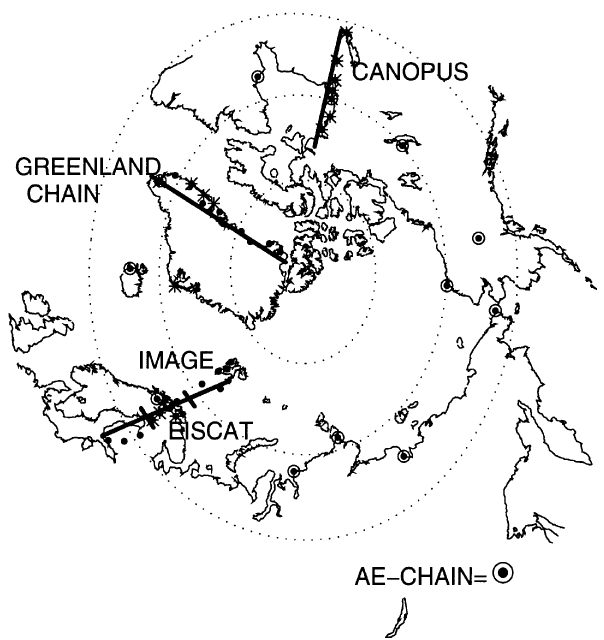
Fig. 1. The AE stations and the IMAGE/EISCAT (EISCAT is the shorter part within the tick marks in the middle of the IMAGE chain), CANOPUS, and Greenland magnetometer chains. The sta- tions used in the case-studies are marked with asterisks . The dotted lines show the corrected geomagnetic latitudes 60, 70, and